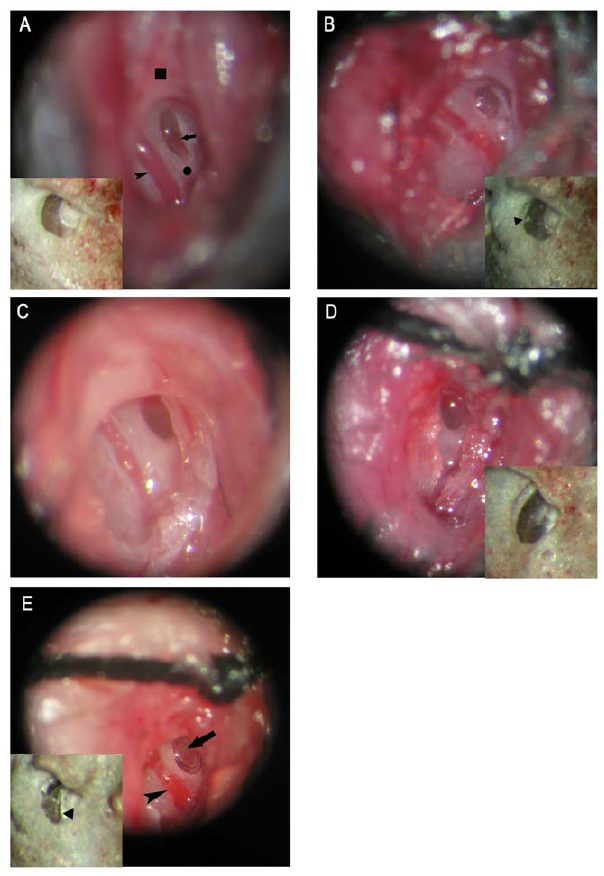
Figure 1. Views of surgical areas showing the conditions of RWM after different treatments. The insert of each image performed RWM in vitro correspondingly. A: control RWM freshly exposed. The RWM was partially covered by a piece of bone, which was routinely removed during surgery. B: Punctured RWM. The punctured point was covered by a small amount of fluid. C: RWM treated with 30 mg/mL collagenase I, revealing intact RWM with slight congestion. D: RWM treated with 60 mg/mL collagenase I. RWM was intact, but apparent congestion was observed in the RWM and nearby soft tissues, and a scar was seen in the middle of RWM in vitro. E: RWM treated with 90 mg/mL collagenase I, resulting in a large perforation of the RWM, indicated by the crosses. Arrow, RWM; arrowhead, stapedial artery; square, wall of the bulla; circle, lower edge of the round window niche; triangle, the perforation observed in RWM. RWM: round window membrane.